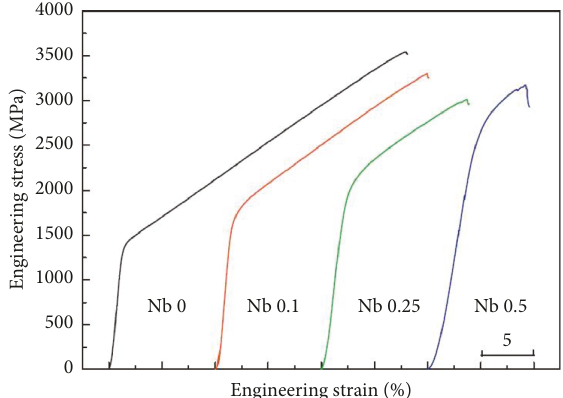
Figure 14: The compressive stress–strain curves of the AlCoCr- FeNb x Ni HEA ( x � 0, 0.1, 0.25, and 0.5) [8]. Table 1: Mechanical properties of AlCoCrFeNb and 0.5) alloy [8].